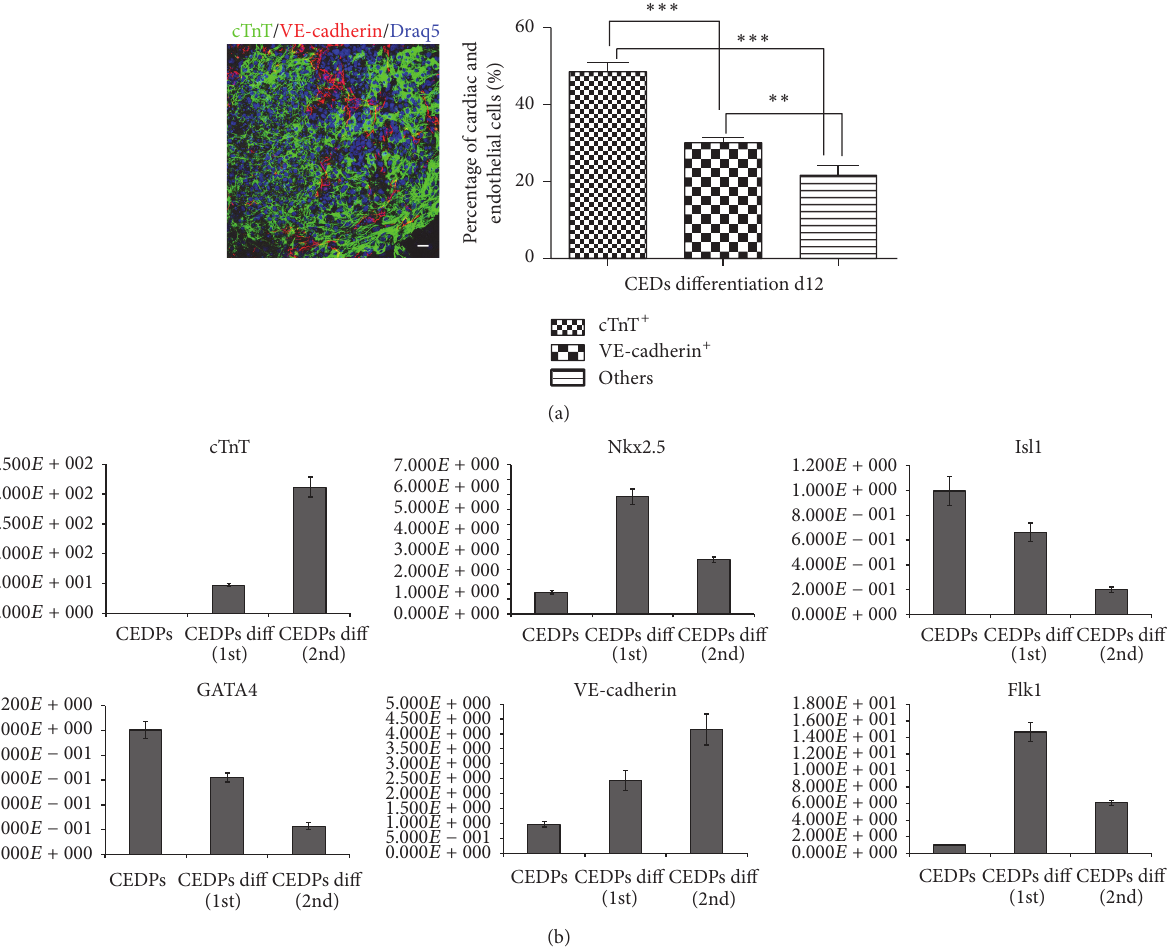
Figure 6: Characterization of CEDPs-derived products. (a) Statistical analysis of cTnT + and VE-cadherin + cells in CEDPs-derived differentiated cells at d12. The total number of cells counted was 10417 in three independent experiments. ∗∗∗ 𝑃 < 0.001 and ∗∗ 𝑃 < 0.01 . Cells from random fields were photographed (as in representative image left) and counted by Fiji cell-counter. Scale bar: 20 𝜇 m. (b) cTnT, Nkx2.5, Isl1, GATA4, VE-cadherin, and Flk1 mRNA levels quantification in CEDPs-derived differentiated cells at d10 by real time qPCR. Results in CEDPs differentiation first and CEDPs differentiation second referred to two independent differentiation